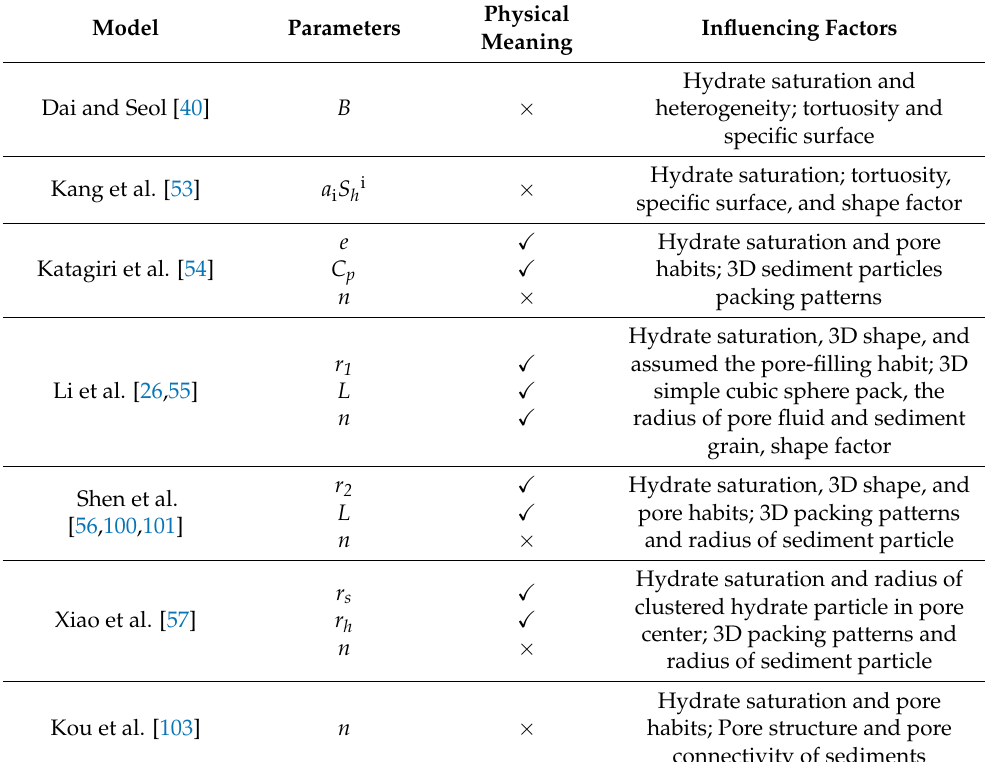
Table 6. Characteristics of modified permeability models for permeability prediction of